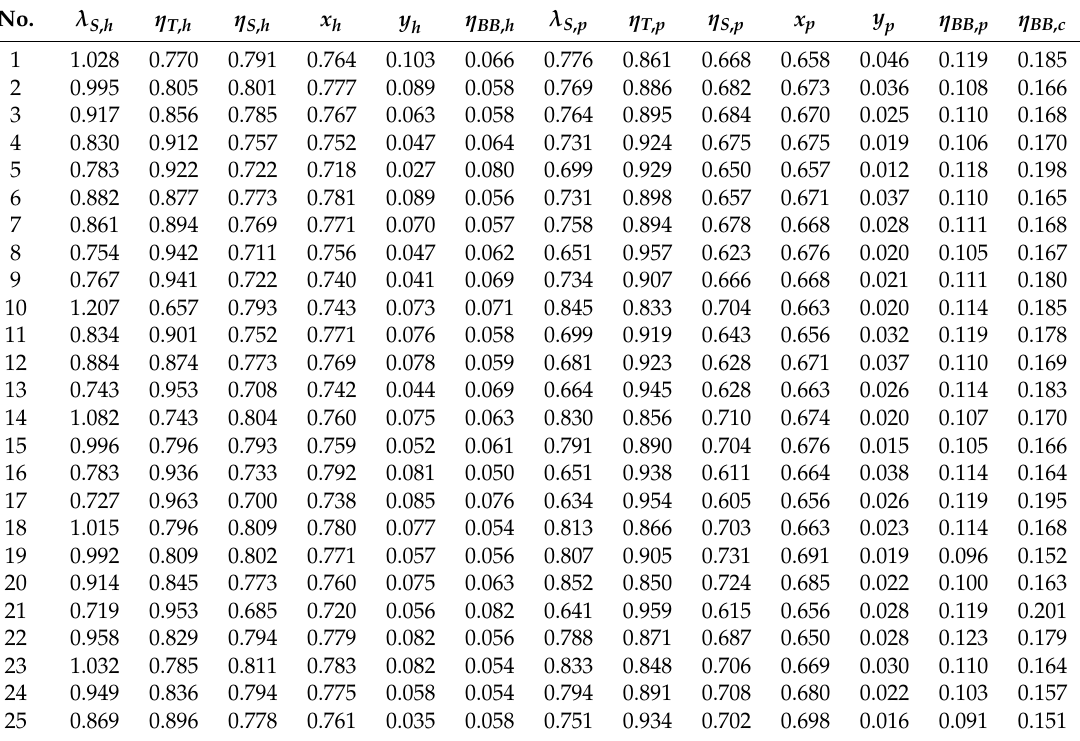
( d ) Figure 12. Comparison between the high load results and the partial load results. ( a ) Scavenging efficiency; ( b ) trapping efficiency; ( c ) delivery ratio; ( d ) evaluation objective function.